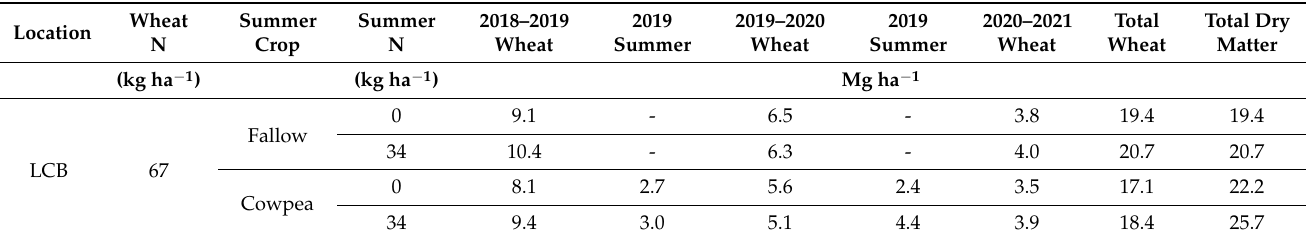
Table A1. Average dry matter biomass production (Mg ha − 1 ) from each season of production for LCB and